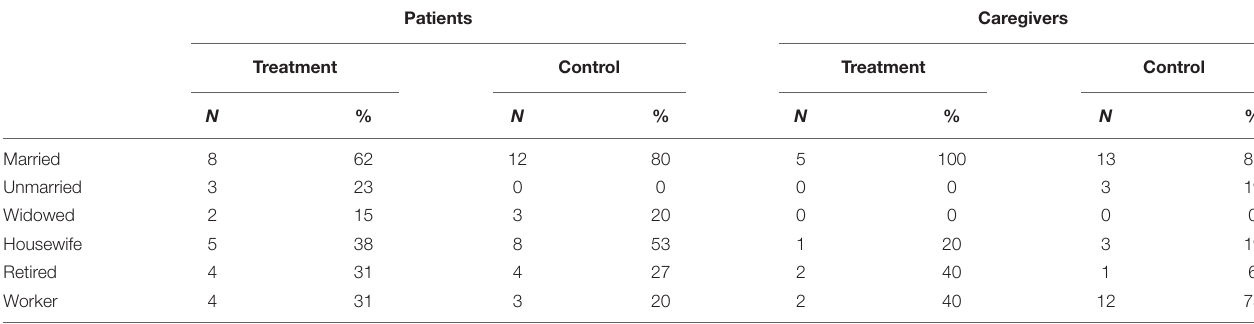
TABLE 1 | Socio-demographic characteristics of patients and caregivers of the four groups. Patients Caregivers Treatment